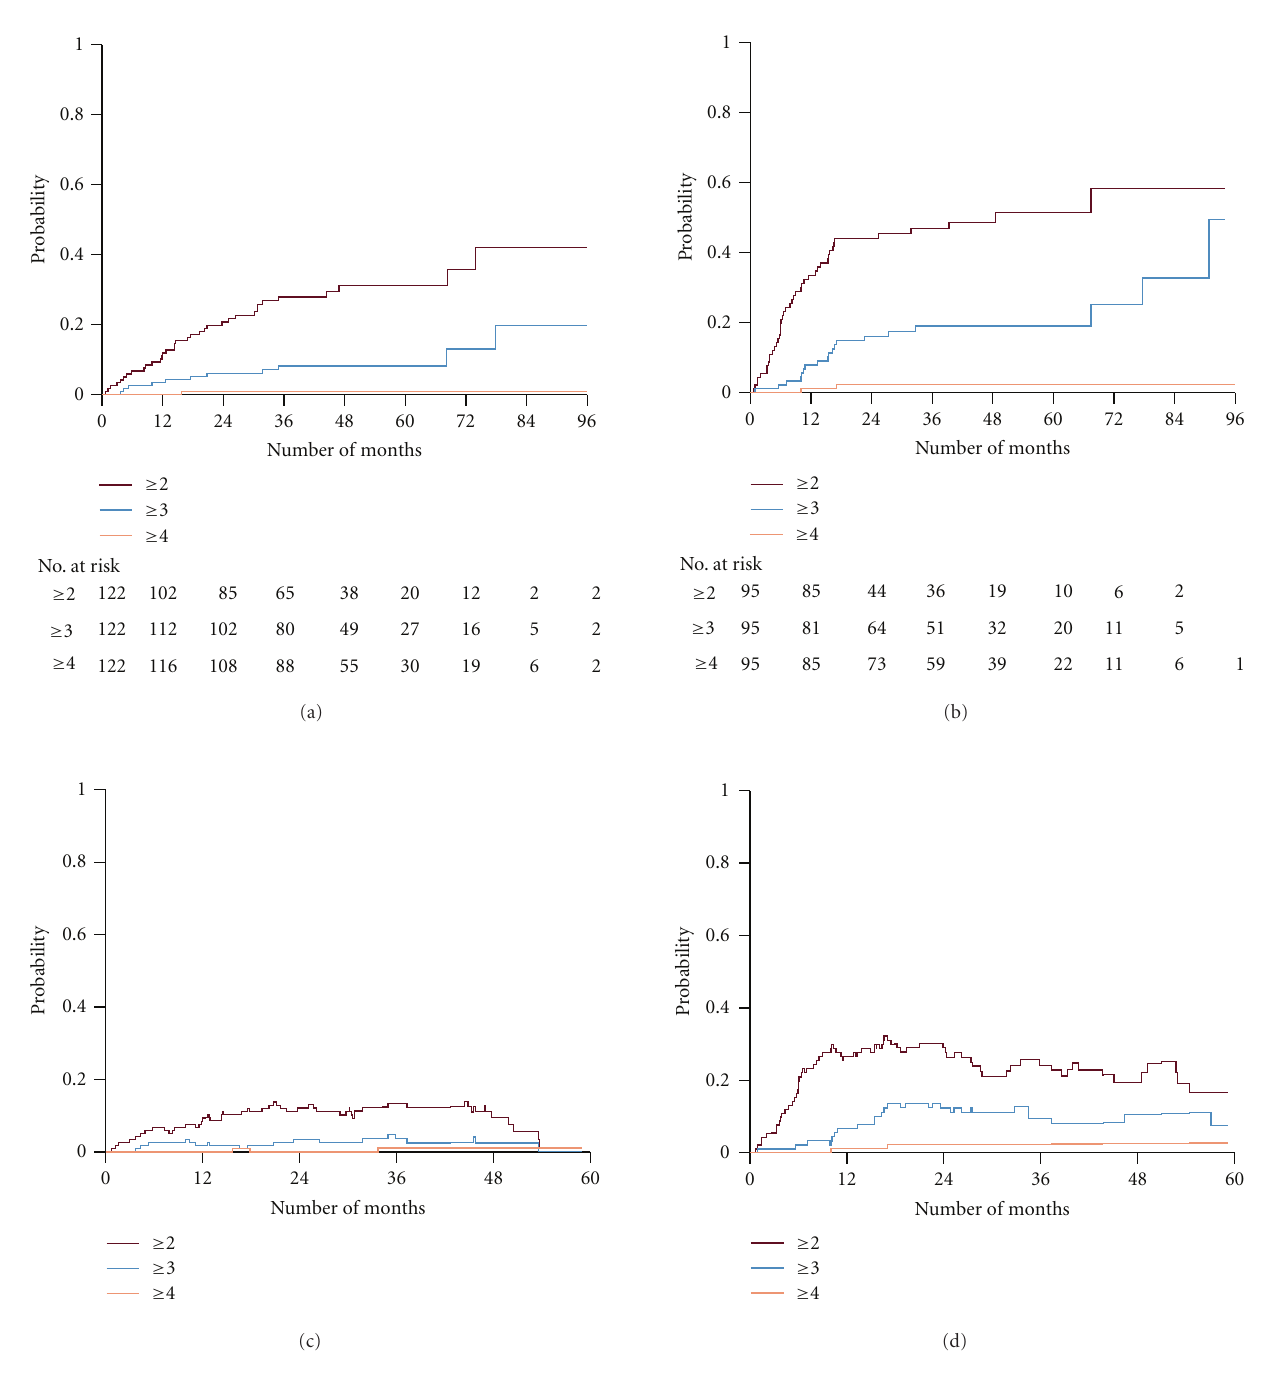
Figure 4: Cumulative probability of a genitourinary (GU) event of given grade, when base line GU level is grade = 0 (panel a) and baseline level GU level is grade = 1 (panel b). (Panels c and d) illustrate the actuarial prevalence of GU events of a given grade when baseline GU is grade = 0 and grade = 1, respectively. Numbers of patients at risk are shown at di ff erent time